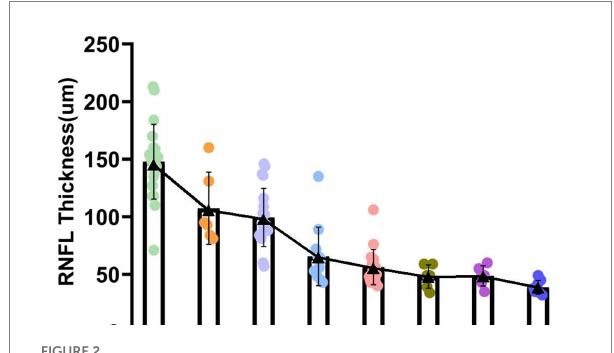
FIGURE 2 Scattered distribution and changes in the average thickness of RNFL with the course of the disease.